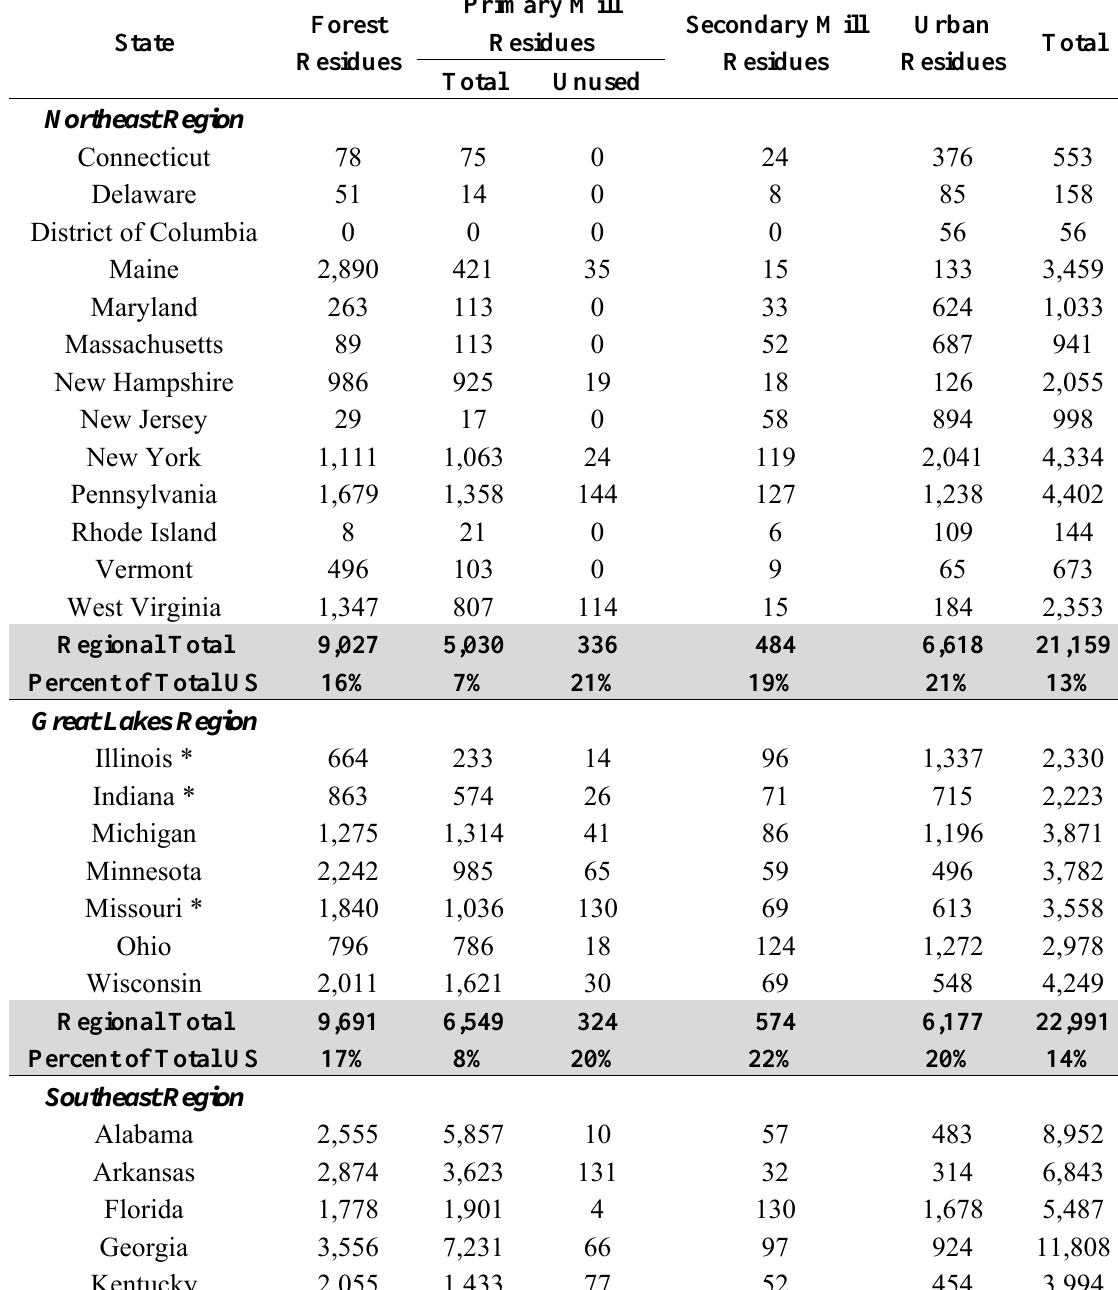
Table 1. Eastern forest mill and urban residues (1000 dry Mg y − 1 )